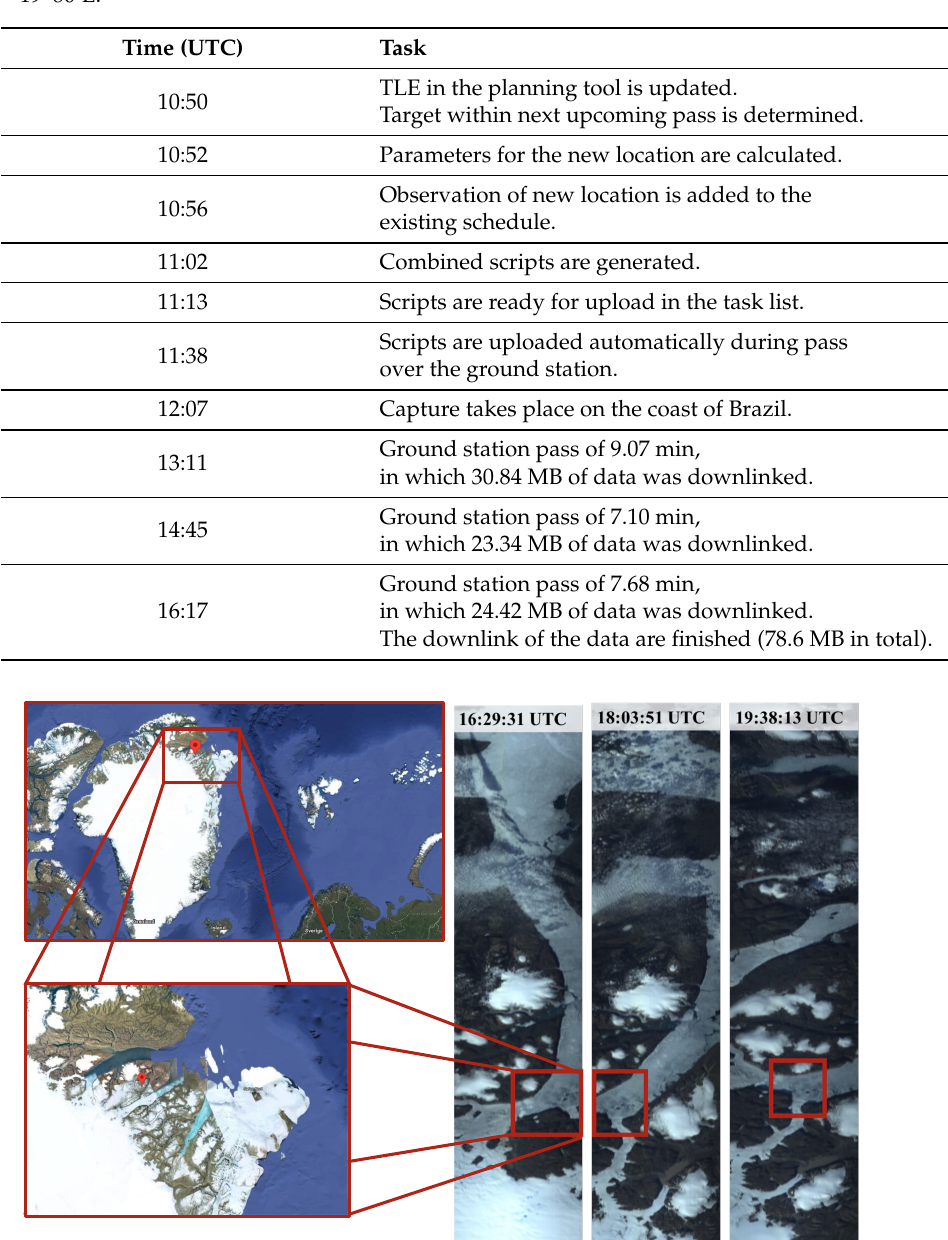
Table 3. Timing schedule of the quick-response planning of capturing the coast of Brazil at − 39 ◦ 83 (cid:48) N,